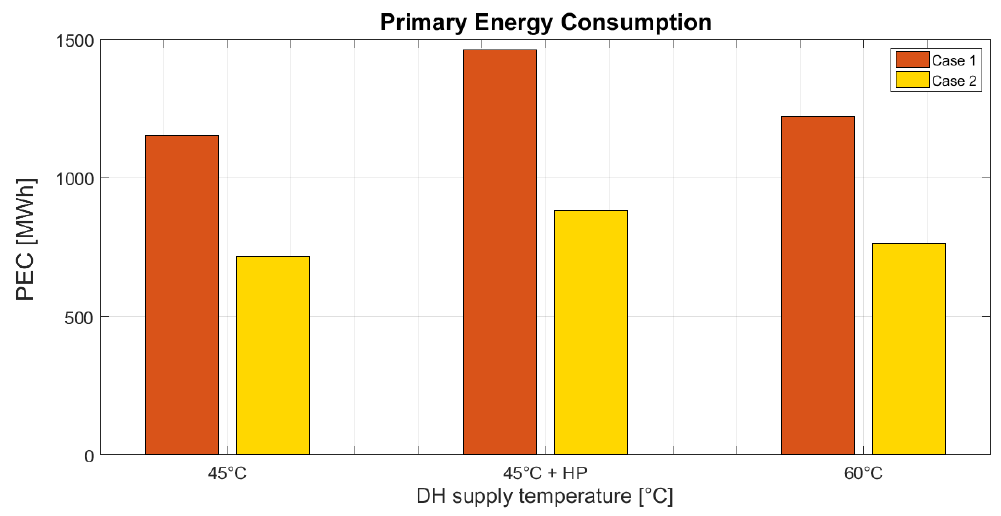
Figure 9. Comparison of annual primary energy